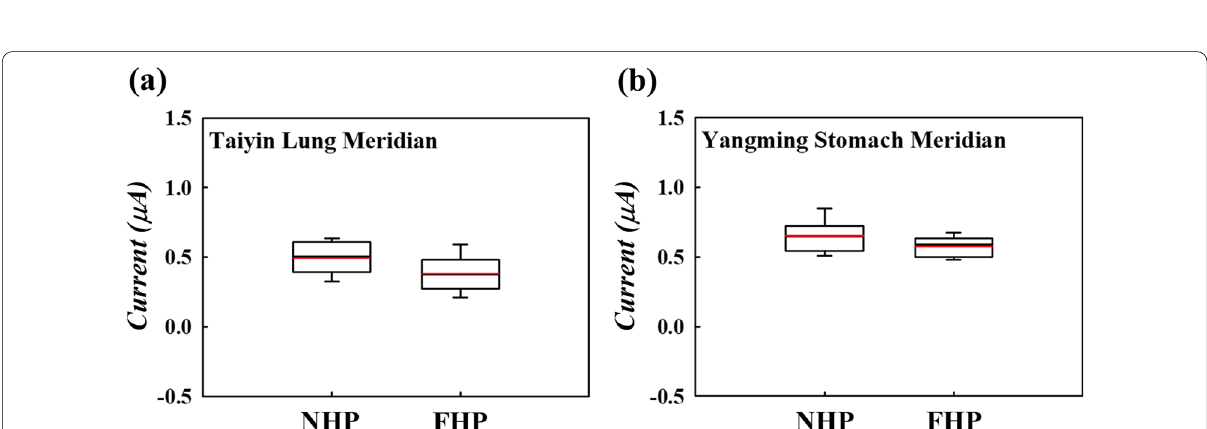
Fig. 9 Box plot of the mean current of the a Taiyin lung meridian and b Yangming stomach meridian. The red line in the box plot is the mean value of the data